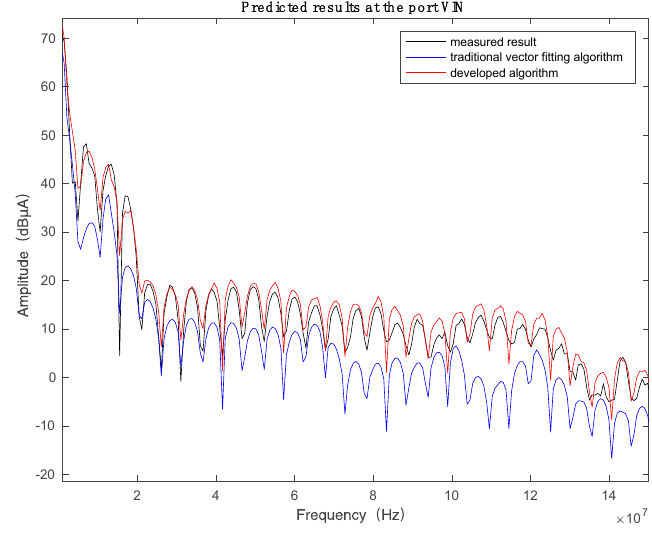
Figure 14. The predicted results at the port VIN.